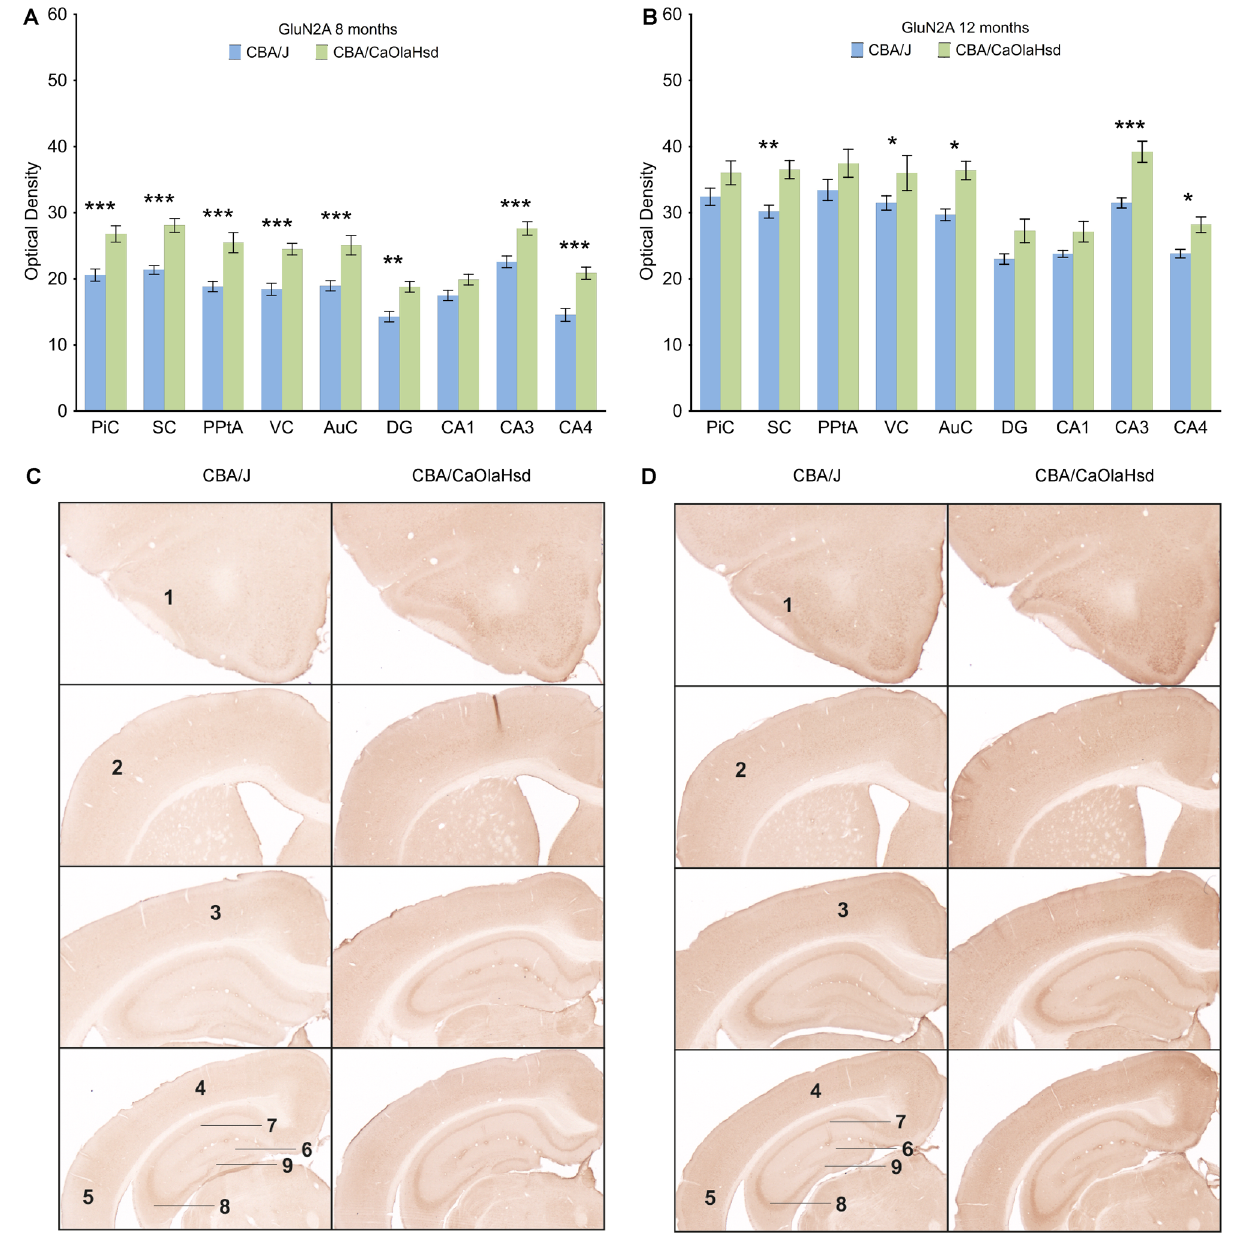
Figure 3. GluN2A expression is reduced in blind mice 8 months and 12 months postnatally compared to CBA/ CaOlaHsd mice. ( A , B ) Bar charts represent mean GluN2A subunit optical densities in different brain regions 8 and 12 months postnatally in CBA/J (blind) mice compared with CBA/CaOlaHsd mice. Except in CA1, subunit density is significantly decreased in the piriform cortex (PiC), somatosensory cortex (SC), posterior parietal cortex (PPtA), visual cortex (VC), auditory cortex (AuC), dentate gyrus (DG), CA3, and CA4 in CBA/J mice 8 months postnatally. 12 months after birth, subunit density is still reduced in somatosensory cortex (SC), visual cortex (VC), auditory cortex (AuC), CA3 and CA4 in CBA/J mice. *P < 0.05; **P < 0.01; ***P < 0.001. ( C , D ) DAB-stained coronary sections showing GluN2A expression in CBA/J and CBA/CaOlaHsd mice 8 and 12 months postnatally. The photomicrographs highlight the changes as described in ( A and B ). 1: piriform cortex, 2: somatosensory cortex, 3: posterior parietal cortex, 4: visual cortex, 5: auditory cortex, 6: dentate gyrus, 7: CA1, 8: CA3, 9: